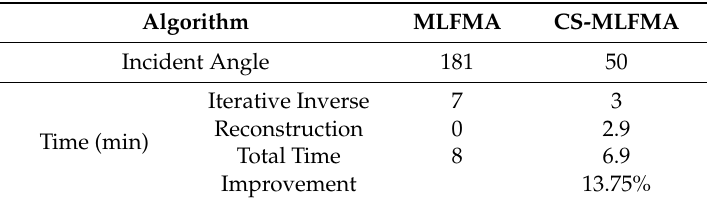
Table 1. Computation time comparison for PEC cube.